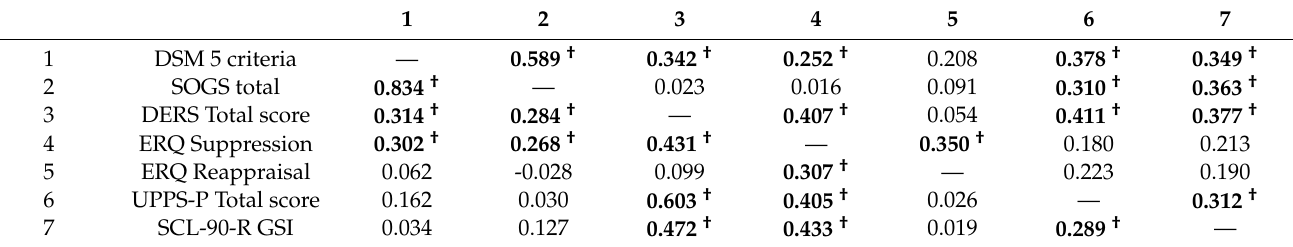
Table 1. Correlation matrix for the main variables of the